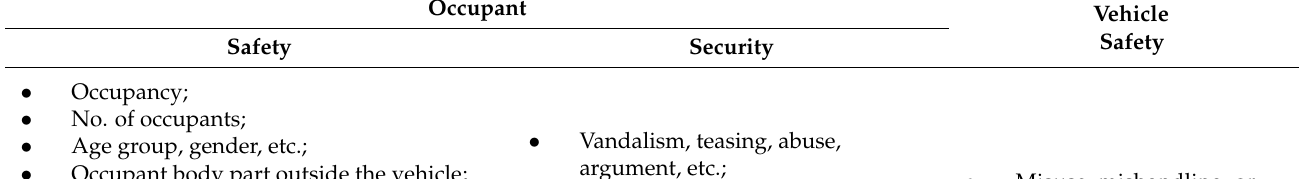
Table 1. The safety and security of the occupants and vehicle in the in-cabin monitoring of AVs. Occupant